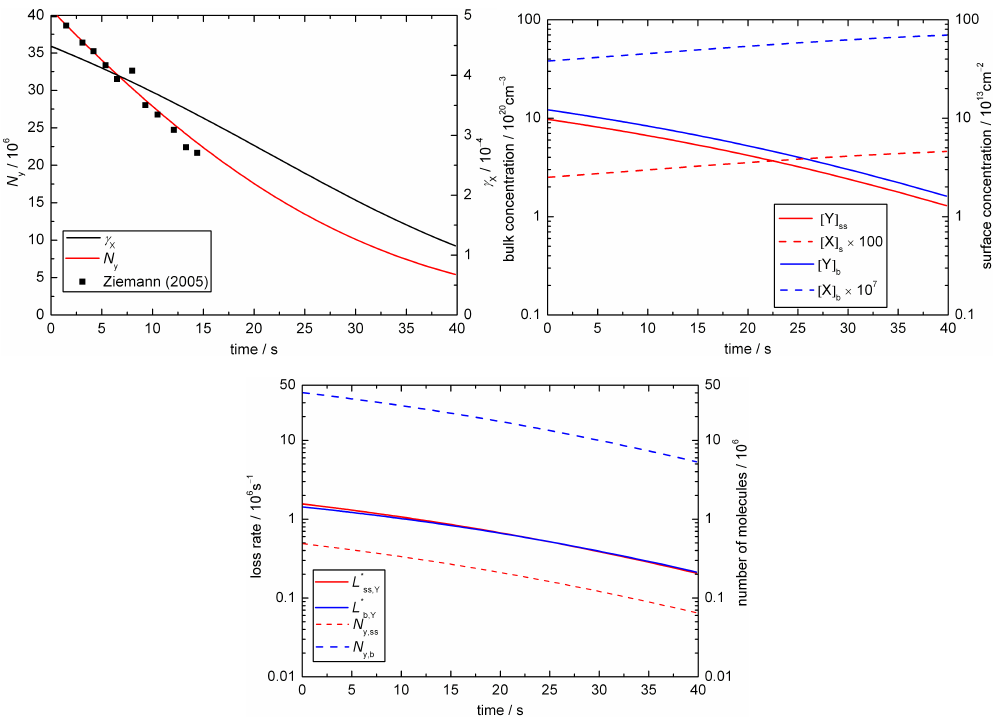
Fig. 8. Temporal evolution of aerosol particle composition and kinetic parameters in base case 2 (BC2; X = O 3 , Y = oleic acid): (a) ozone uptake coefficient ( γ x ) and total number of oleic acid molecules ( N y ; symbols indicate experimental data from Ziemann, 2005); (b) surface and bulk concentrations (square brackets); (c) numbers of oleic acid molecules at the surface and in the bulk of the particle ( N y , ss , N y , b ) and = L ss , Y × A ss , L ∗ = L × V corresponding absolute loss rates ( L ∗ b , Y b ) ss , Y b , Y